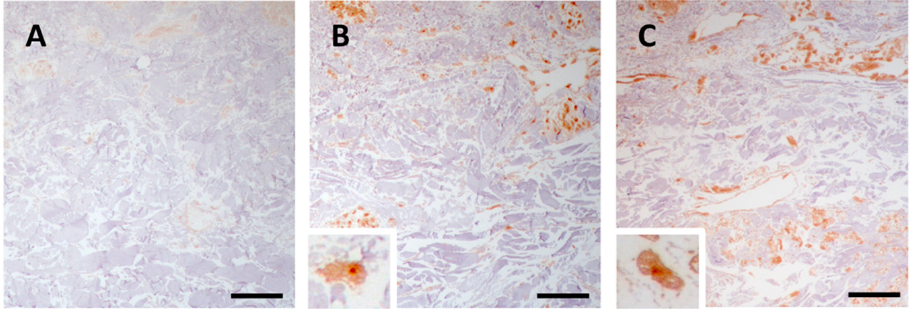
Figure 5. Representative images of immunohistochemistry for p-SMAD1/5/8 in skin samples obtained from the control subject ( A ) and from clinically unaffected ( B ) and affected ( C ) areas in the same PXE patient. Scale bar = 50 µm.